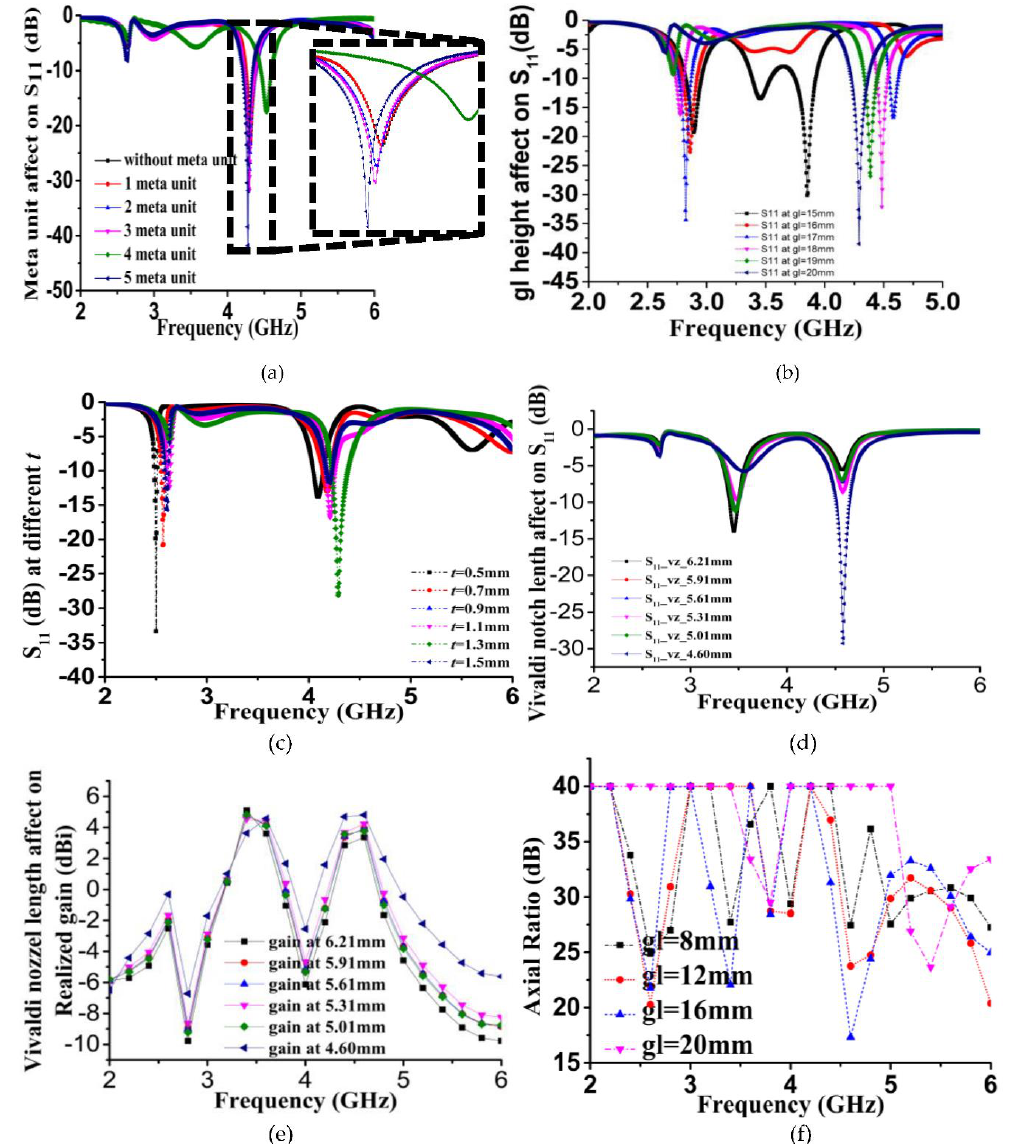
Figure 5. Performance analysis using parametric variation: ( a ) Number of metamaterial unit cell variation and ( b ) ground plane height affects ( c ) substrate thickness, ( t ) variation; ( d ) slotted notch length effect on the reflection coefficient (S 11 ) ( e ) realized gain vs. slotted notch variation; ( f ) axial ratio vs. ground plane height variation.